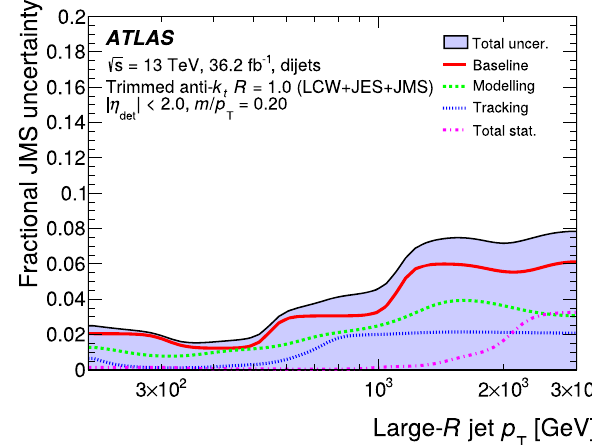
Fig. 17 Thetotaluncertaintyintherelativejetmassscalebetweendata and simulation associated with the R trk method is plotted as a function of jet transverse momentum p T for large- R jets with m / p T = 0 . 2. The large- R jet p T is corrected using the simulation calibration, η - intercalibration, and a combination of in situ direct balance techniques. Fig. 16 Measurementof R m asafunctionofthelarge- R jettransverse The contributions from several sources are indicated. The baseline trk momentum p T for large- R jets with m / p T = 0 . 2. The large- R jet p T uncertainty represents the deviation of the double ratio from unity for is corrected using the simulation calibration, η -intercalibration, and a the baseline simulations. The lines shown are obtained by smoothing combination of in situ direct balance techniques. Data are compared a binned representation of these uncertainties using a sliding Gaussian with three generators and with three tracking variations for the default generator Pythia 8 (shown as a band around these points). The double ratio of R m measured in simulations and data is shown in the lower trk panel